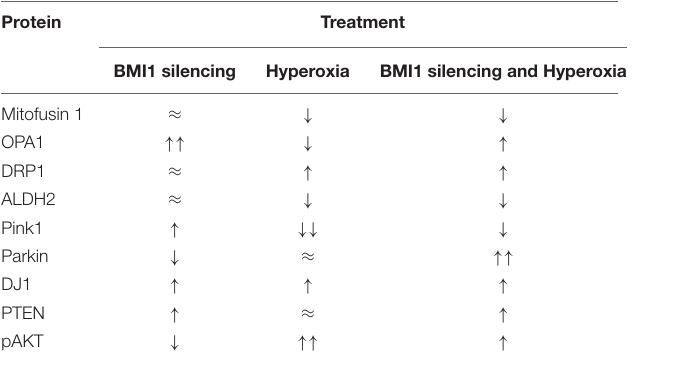
TABLE 2 | Effect of Hyperoxia and BMI1 silencing in protein expression levels of mitochondrial biomarkers and regulatory proteins of mitochondrial function. Protein